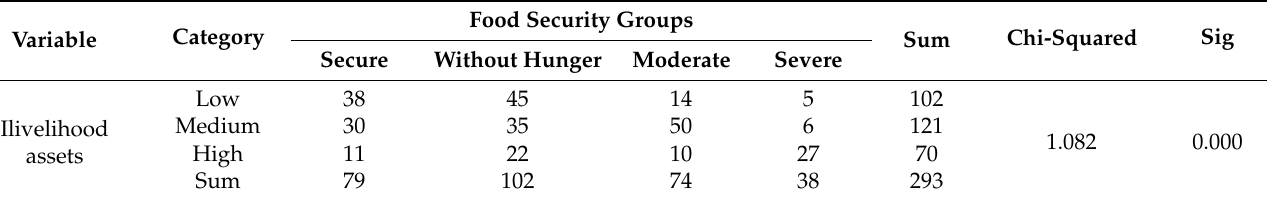
Table 5. Distribution livelihood assets and food security.